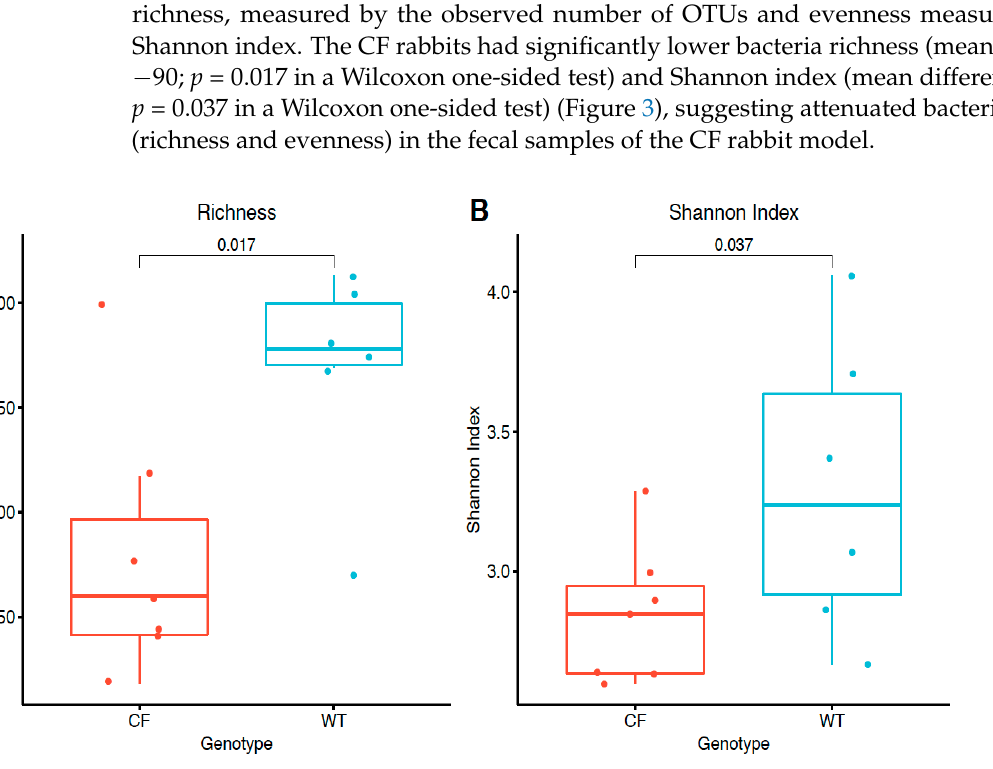
Figure 3. Sample alpha diversity in CF and WT groups. ( A ) Richness measured by the observed number of OTUs. ( B ) Evenness measured by the Shannon index. The distributions of values were summarized by boxplots. Shown from bottom to top is the minimum value, first quartile, median, third quartile, and maximum value, and the outlier value is shown as individual points. On top of the boxplots, the individual data points were super imposed; p -values were calculated by a one-sided Wilcoxon rank sum test.